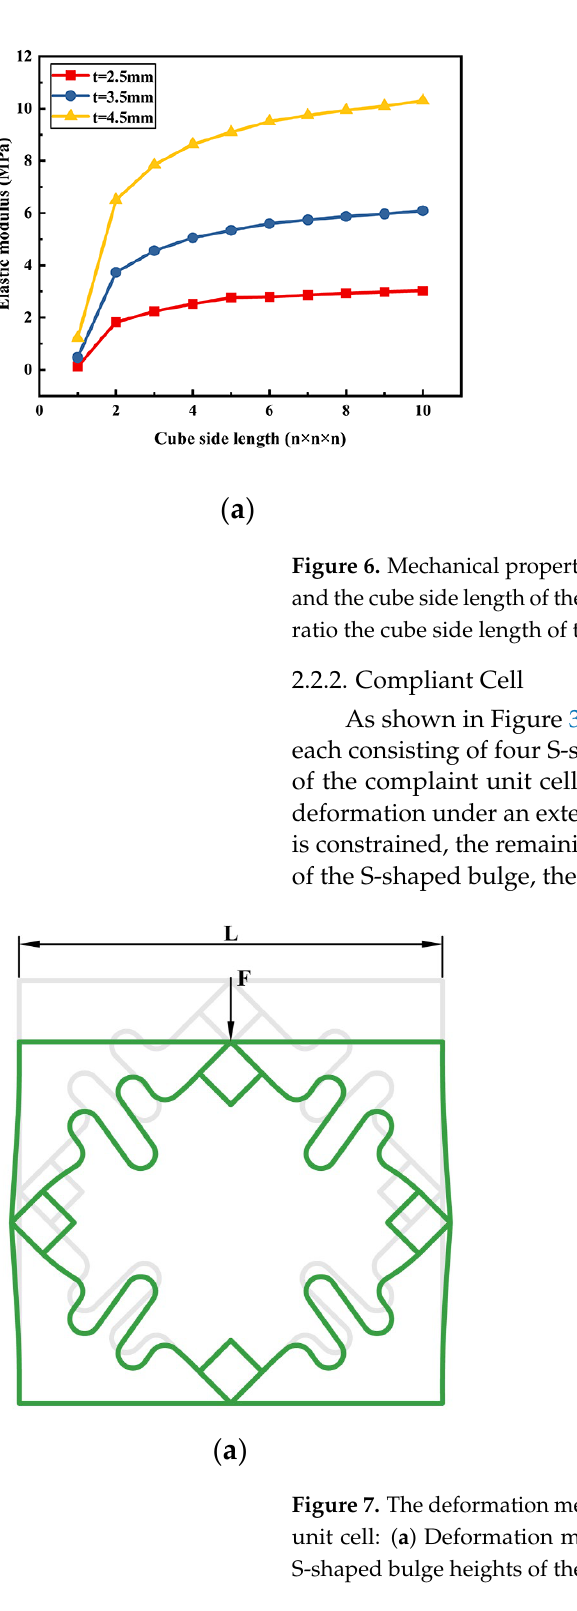
( b ) Figure 8. Mechanical properties of the compliant lattice with different S-shaped heights: ( a ) The relationship between the elastic modulus and the cube side length (with H = 0.1–0.2 L); ( b ) The relationship between the Poisson’s ratio and the cube side length (with H = 0.1–0.2 L). Furthermore, the influence of different widths of the S-shaped bulge and beam sec- tion sizes on its mechanical properties is also analyzed parametrically here. Figure 9 illus- trates the schematic diagram of different widths of the S-shaped bulge and beam section size of the compliant cell. Figure 10a,b present the elastic modulus curve and the Poisson’s ratio curve of the compliant lattice as the S-shaped beam widths changes from W = 0.05 L to W = 0.09 L, with a beam section size of 2.5 mm × 2.5 mm and a height of the S-shaped bulge of 0.2 L. Figure 10c,d show the influence of different beam sizes (t = 0.5 mm, 1.5 mm,